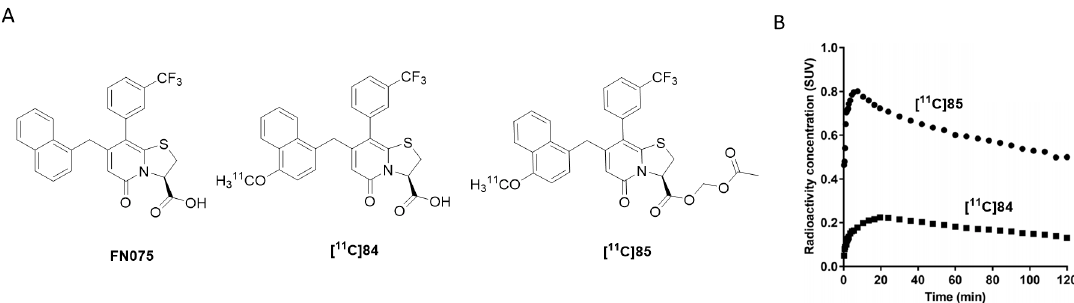
Figure 28. The chemical structures of FN075 and its analogues. ( A ) The chemical structures of FN075 and radiolabeled acetoxymethyl ester [ 11 C]84 and [ 11 C]85 . ( B ) TACs in the whole brain derived from healthy NHP following the IV injection of [ 11 C]84 and [ 11 C]85 (reprinted with permission from [146]. Copyright 2018 American Chemical Society).